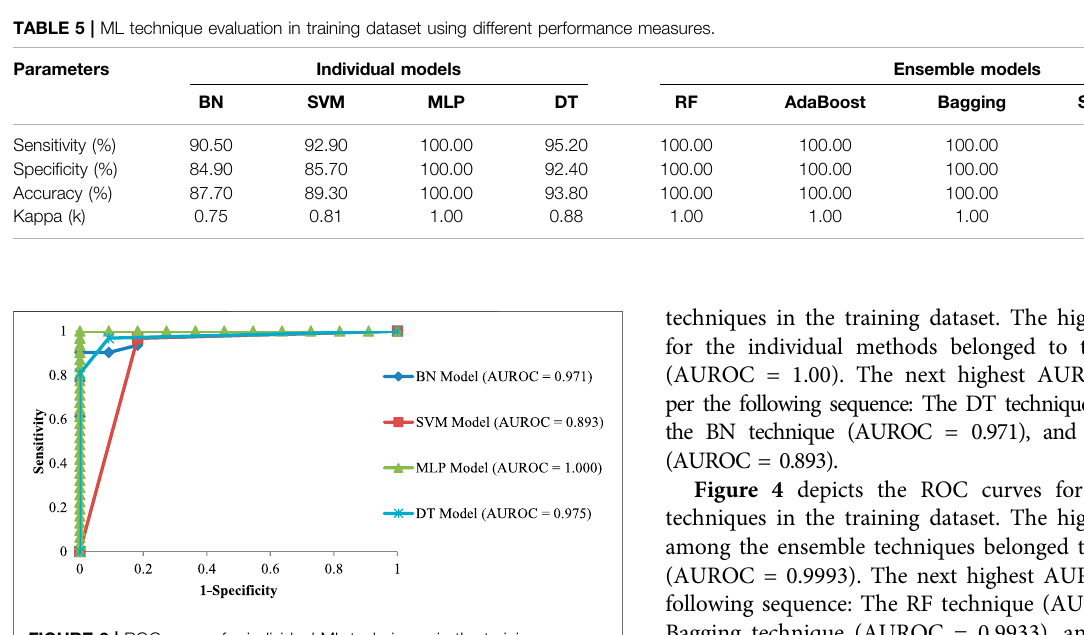
FIGURE 3 | ROC curves for individual ML techniques in the training